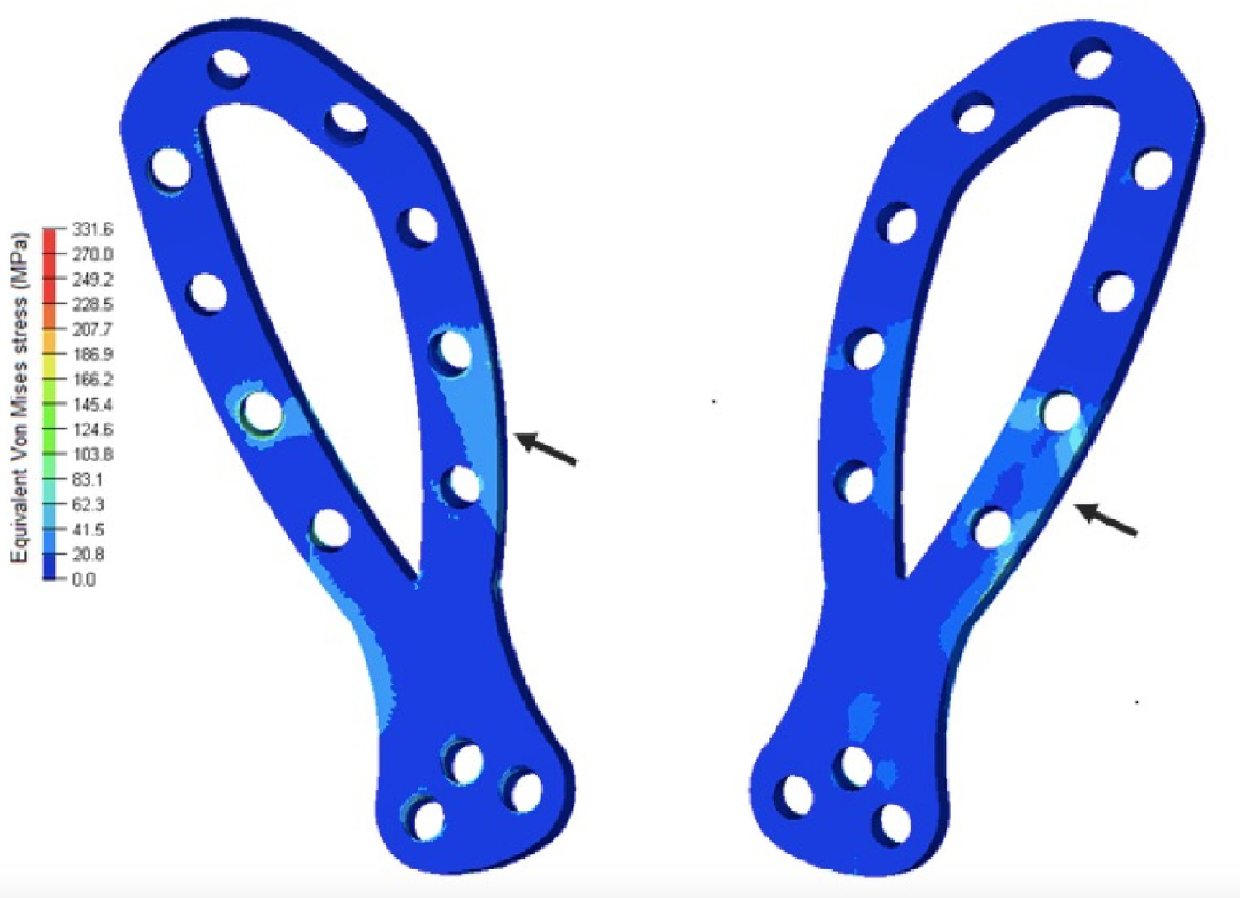
Fig 6. Von Mises stress in megapascals in the internal and external region for the novel iliac plate.